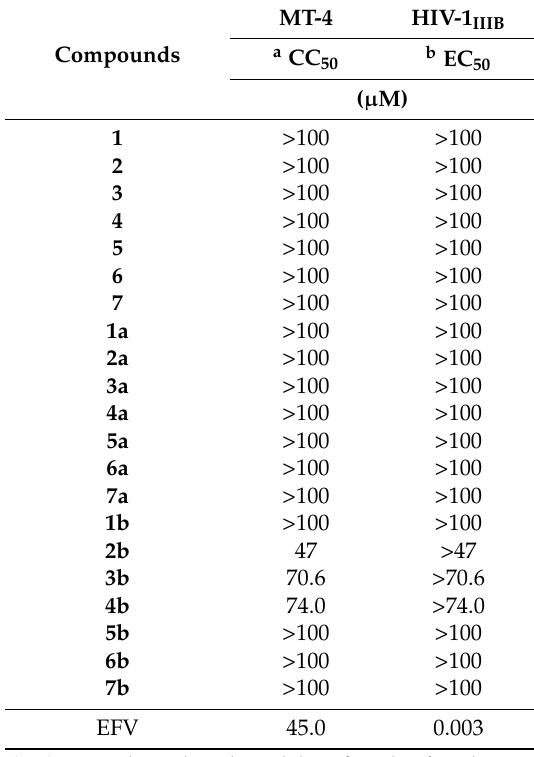
Table 2. Cytotoxicity and anti-HIV-1 activity of compounds ( 1 – 7 , 1a – 7a and 1b – 7b ).